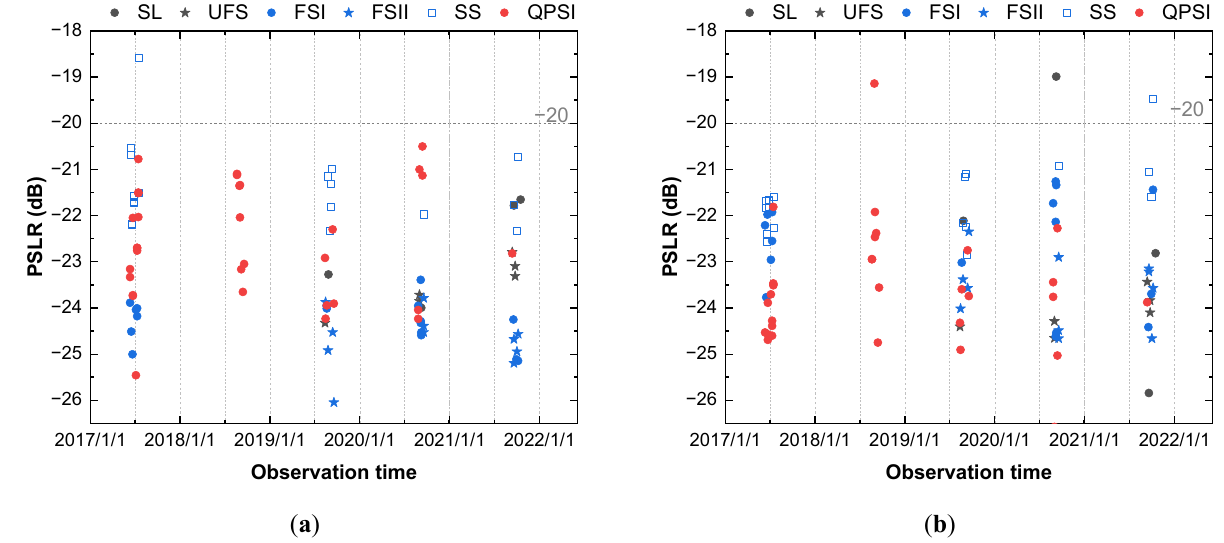
Figure 7. GaoFen-3’s PSLR evaluation on single-pol, dual-pol, and quad-pol datasets for the Inner Mongolia calibration site from June 2017 to October 2021. ( a ) and ( b ) are the results in the range and azimuth directions, respectively.